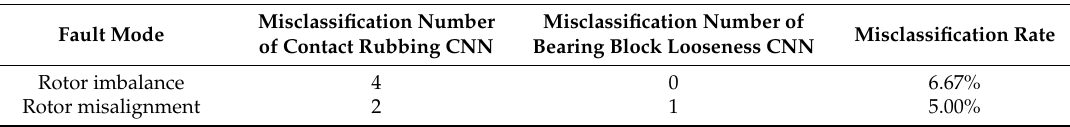
Table 7. Misclassification numbers and rates when acceleration data of rotor imbalance and rotor misalignment are presented for acceleration